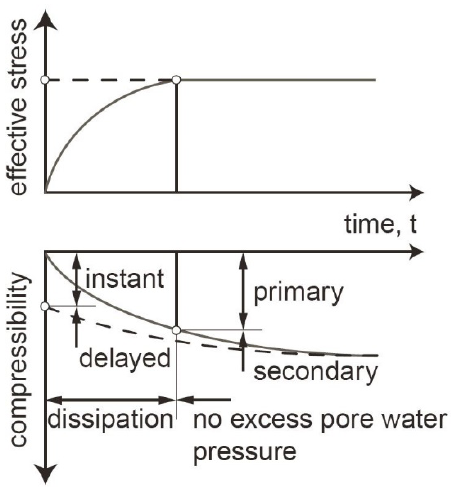
Figure 8: Instant and delayed deformations according to Bjerrum